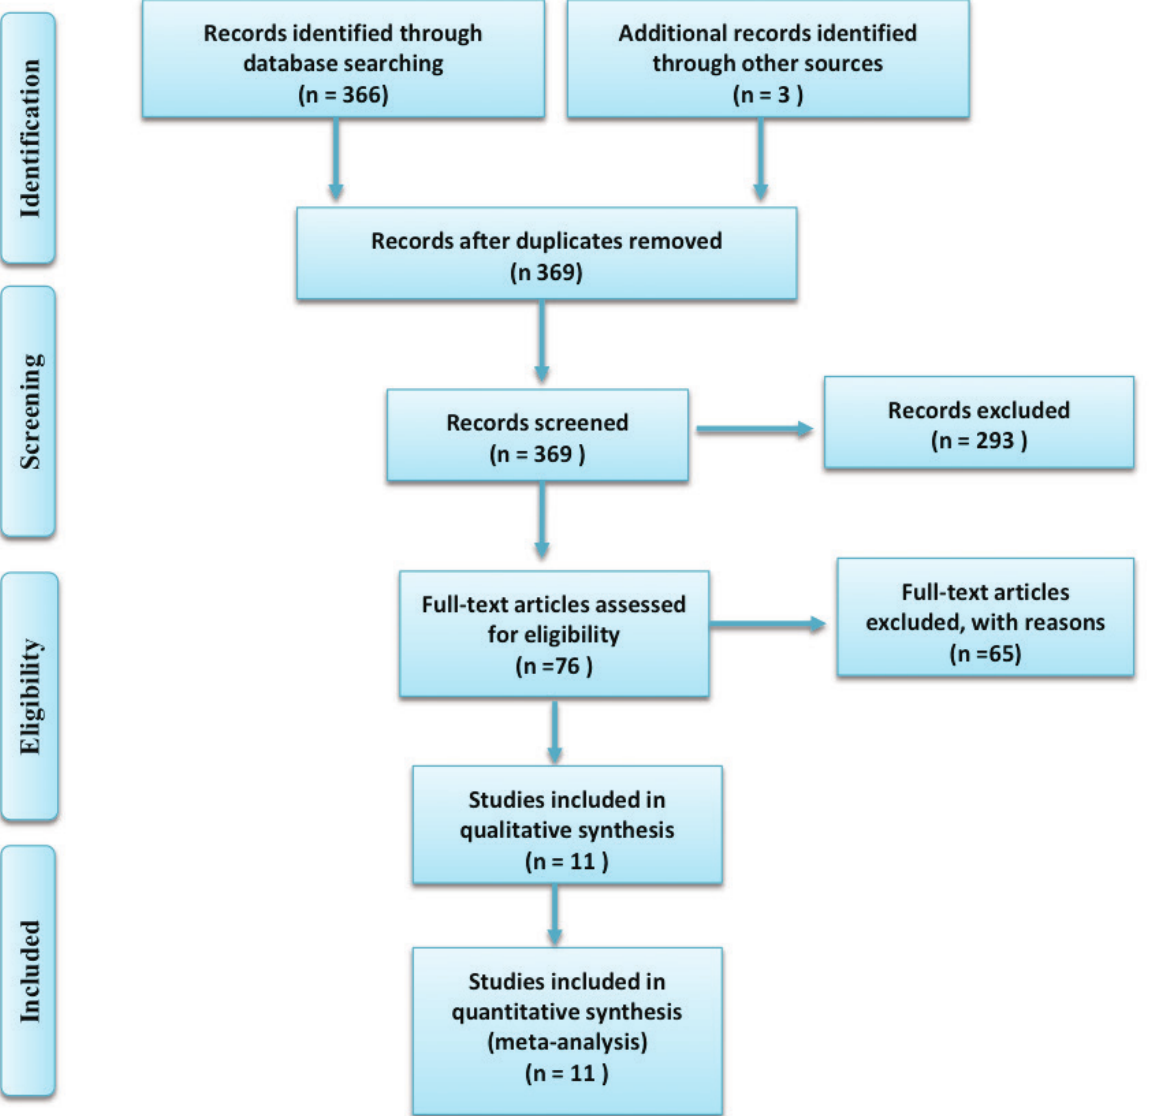
Figure 1: The searching flow chart of this bodies present in the remaining neurons. At present, the most effective treatment for PD is levodopa combined with dopa decarboxylase inhibitors. However, long-term use of these drugs can lead to dyskinesia, “agent end effect” and “open - pass” phenomenon and other adverse reactions.